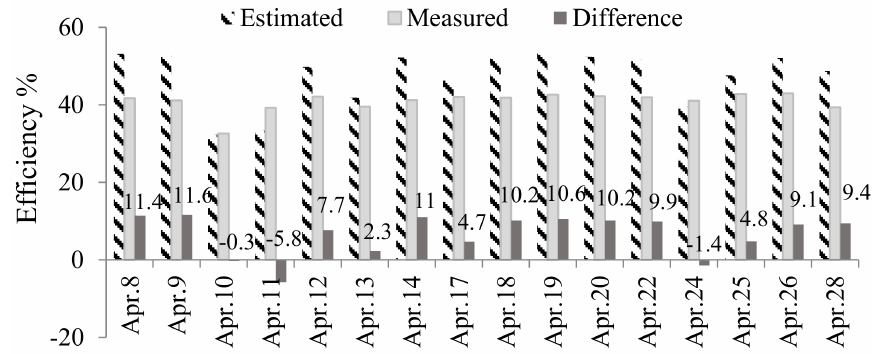
Figure 8. Predicted vs. experimental daily thermal efficiency during April